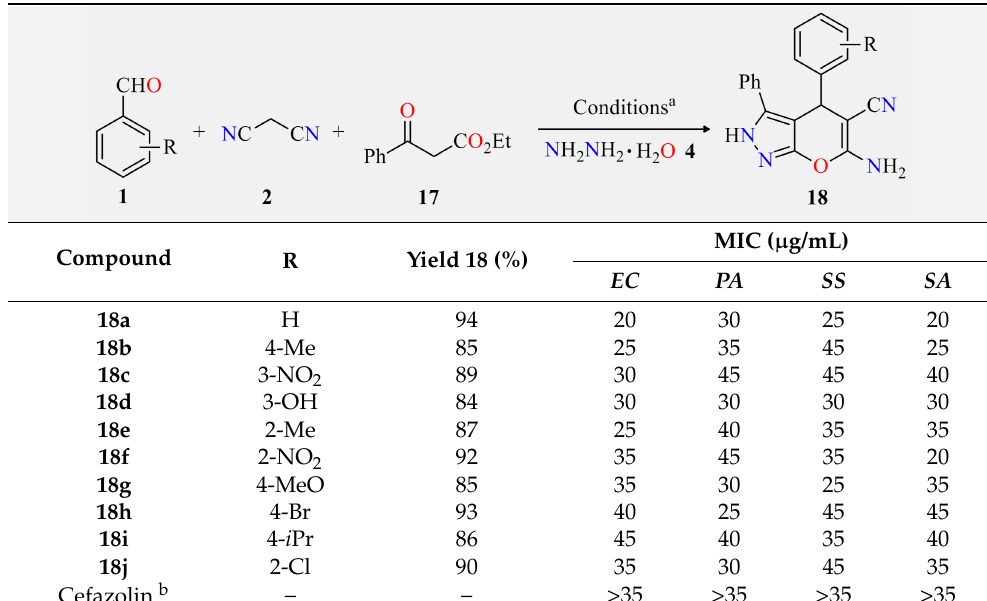
Table 3. Ultrasound-assisted four-component synthesis of pyrano[2,3- c ]pyrazoles 18 as antimicrobial